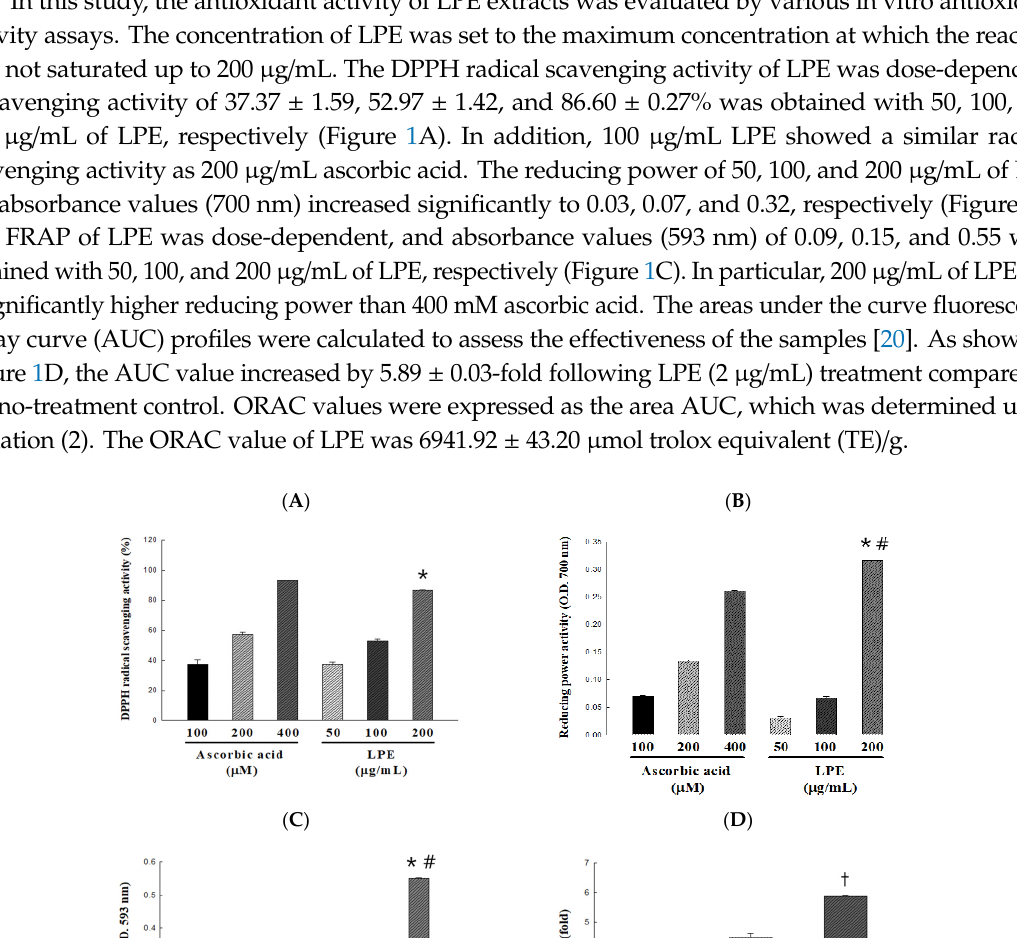
Table 1. Quantification of antioxidant components in LPE.